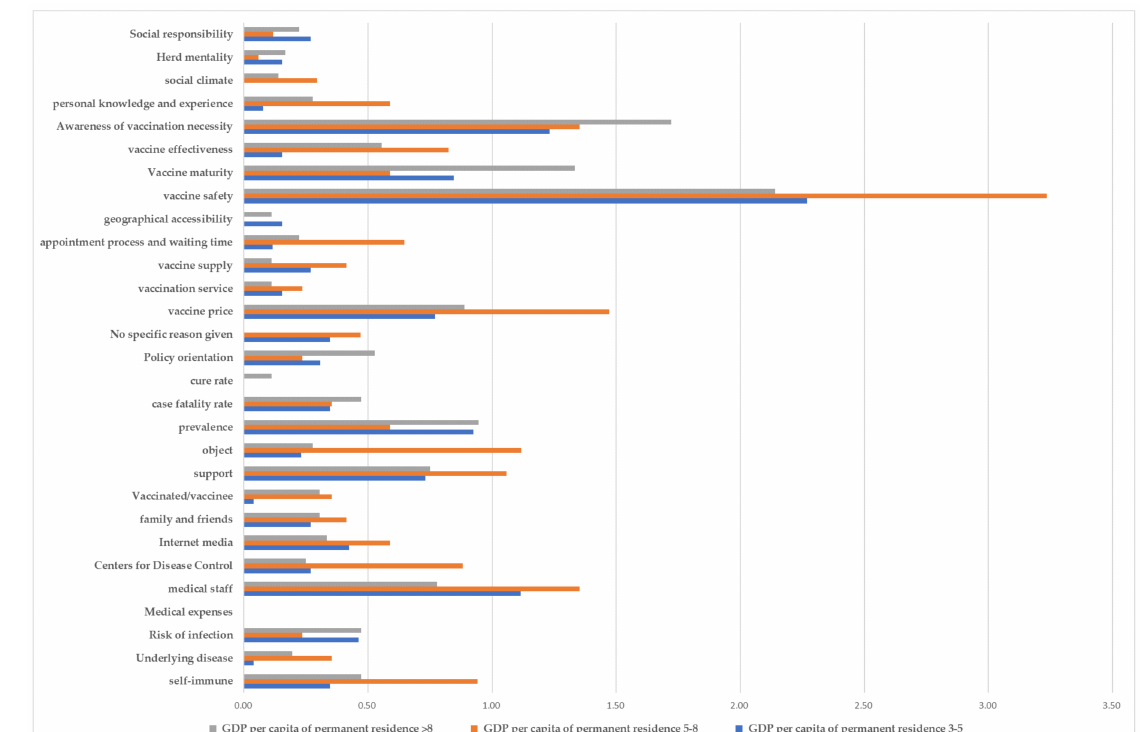
Figure 2. Frequency distribution of factors influencing vaccine hesitancy based on the 2020 per capita gross domestic product of each province according to the National Bureau of Statistics of China